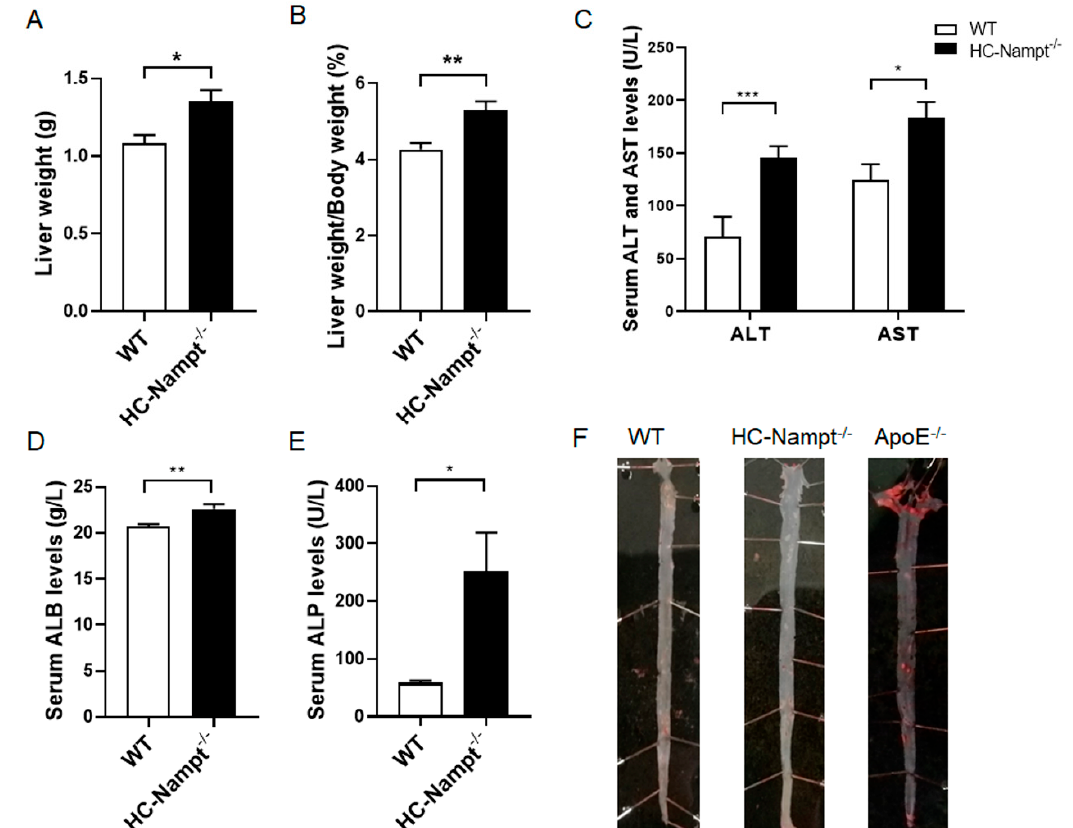
Figure 5. The effects of hepatic Nampt deficiency on liver weight, liver function, and atherosclerotic plaque formation in mice fed a HFD. ( A , B ) Liver weight ( A ) and the liver index, i.e., the ratio of the liver weight to the body weight ( B ) in HC-Nampt -/- and WT mice after 10 weeks of HFD. ( C – E ) Serum liver functional indexes of HC-Nampt -/- and WT mice after 10 weeks of HFD. ALT, alanine aminotransferase; AST, aspartate aminotransferase; ALB, albumin; ALP, alkaline phosphatase. ( F ) Representative images of oil red O staining on the aortas of HC-Nampt -/- and WT mice after 10 weeks of HFD. The ApoE -/- mice aorta used as a positive control. Data are expressed as the mean ± SEM. n = 6 (WT) or 8 (HC-Nampt -/- ). * p < 0.05 and ** p < 0.01 between two groups by two-tailed Student’s t -test.